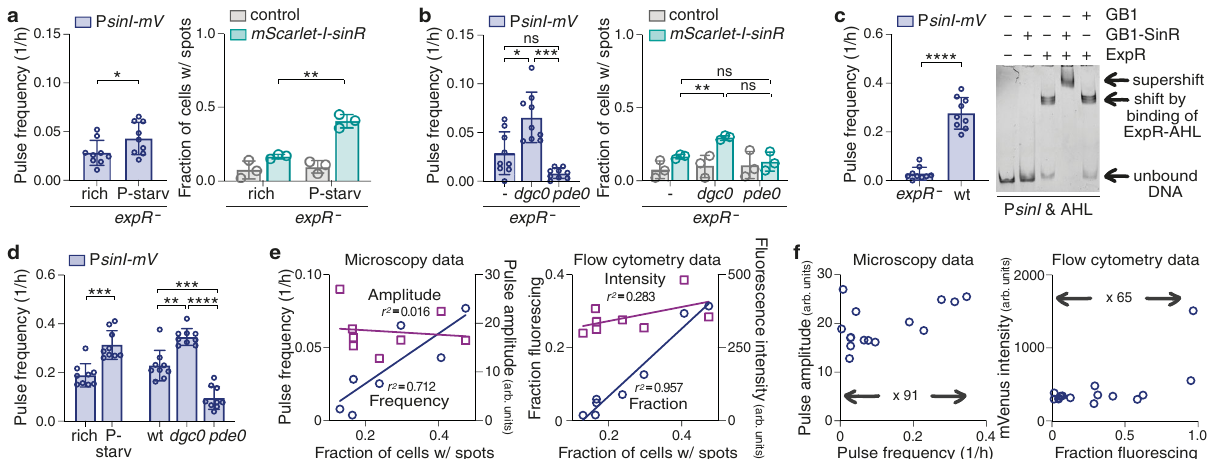
Fig. 3 Physiological factors modulate pulse frequency by changing SinR abundance and DNA binding af fi nity. a , b Phosphate starvation ( a ) and cyclic- di-GMP levels ( b ) modulate both (left, respectively) the frequency of sinI expression pulses and (right, respectively) the fraction of cells displaying mScarlet-I-SinR spots in corresponding patterns. c (Left) The wild type with AHL-induced positive feedback likewise displays elevated sinI expression pulse frequency compared to the expR − strain. (Right) EMSAs indicate that the AHL receptor increases SinR binding af fi nity to the sinI promoter: His-GB1-SinR does not induce a shift of sinI promoter DNA, but causes a supershift in the presence of His-ExpR-AHL. His-GB1-SinR, 70 µ M; His-GB1, 70 µ M; His-ExpR, 1 µ M; AHL, 10 µ M. EMSA representative of 3 independent experiments. d Modulation of sinI expression pulse frequency by (left) phosphate starvation and (right) c-di-GMP levels in the wild type. a – d Bar plots show means± standard deviations and individual data from (turquois) single-molecule microscopy performed in 3 biological replicates and (blue) time-lapse fl uorescence microscopy of 9 colonies imaged on 3 different days. Statistical tests, two-tailed unpaired t -tests with Welch ’ s correction for ( a , c , d (left)); Welch ’ s ANOVA tests with post hoc Dunnett ’ s T3 multiple comparisons test for ( b , d (right)). ns, not signi fi cant; *, P < 0.05; **, P < 0.01; ***, P < 0.001; ****, P < 0.0001. P values (multiplicity-adjusted, if appropriate): rich vs. P-starv in expR − , 0.0324 (pulse data), 0.0066 (SMM data) ( a ); expR − vs expR − dgc0 0.0146 (pulse data), 0.0012 (SMM data), expR − vs. expR − pde0 0.0661 (pulse data), 0.7482 (SMM data), expR − dgc0 vs. expR − pde0 0.0003 (pulse data), 0.1039 (SMM data) ( b ); expR − vs. wt, <0.0001 (pulse data) ( c ); rich vs . P-starv in wt, 0.0002 (pulse data) ( d (left)); wt vs. dgc0 , 0.0010, wt vs. pde0 , 0.0004, dgc0 vs. pde0 < 0.0001 (all pulse data) ( d (right)). Total number of cells analysed: